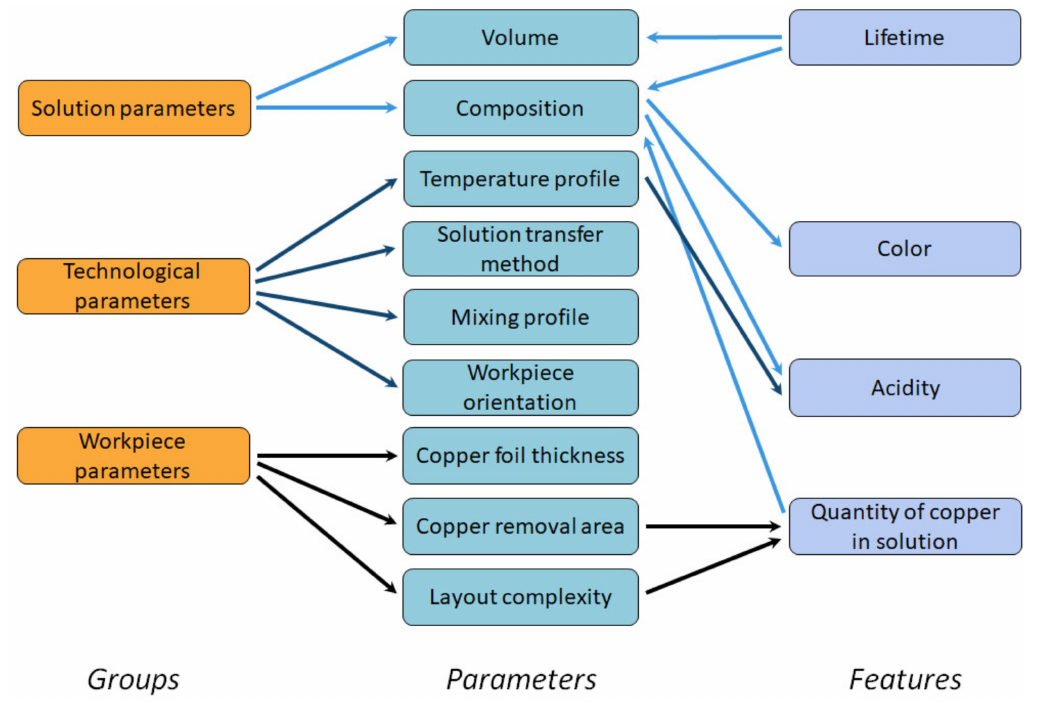
Figure 7. Process parameters that affect the etching